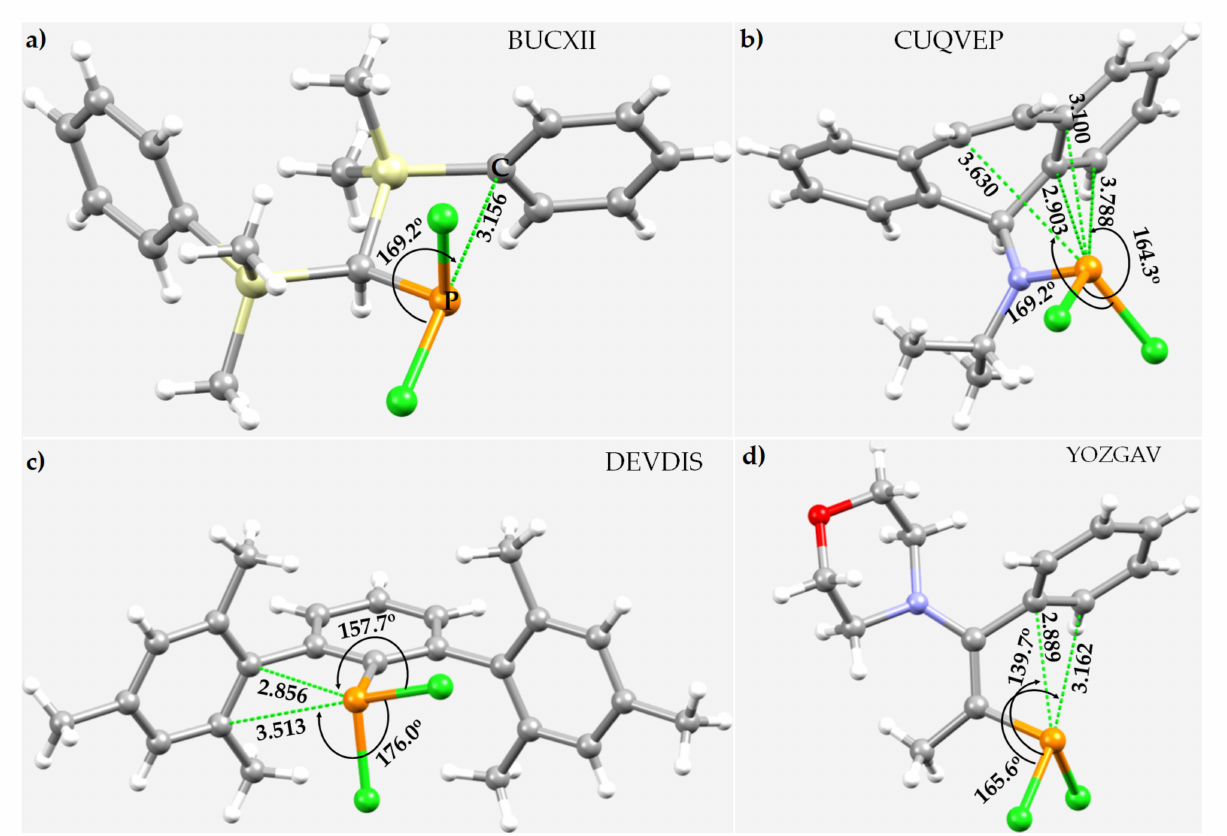
Figure 16. The P ··· π (C/C=C) intramolecular pnictogen bonding interactions in the crystals of ( a ) (bis(dimethyl(phenyl)silyl)methyl)(chloro)phosphine, ((CH 3 ) 2 SiPh) 2 CH(PCl 2 ) [120]; ( b ) N -(2,3:6,7- dibenzohepta-2,4,6-trienyl)- N -(dichlorophosphino)isopropylamine, RN(iPr)(PCl 2 ) [121]; ( c ) dichloro- (2,6-bis(2,4,6-trimethylphenyl)phenyl)phosphane, RPCl 2 [122]; and ( d ) 2-(dichlorophosphanyl)-1- morpholino-1-phenylpropene, 2-R-PCl 2 [123]. Selected bond distances and angles are in Å and degrees, respectively. CSD reference is shown for each case. The dotted line in green represents the intramolecular